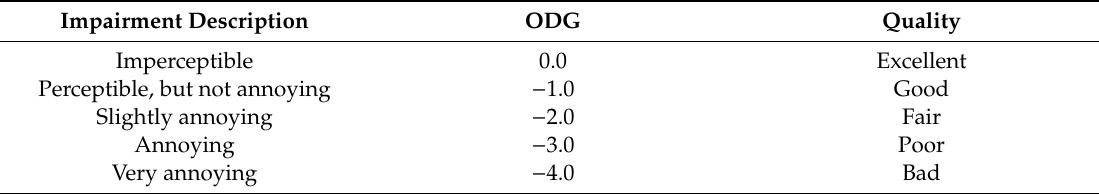
Table 1. Objective di ff erence grades (ODG) for audio quality